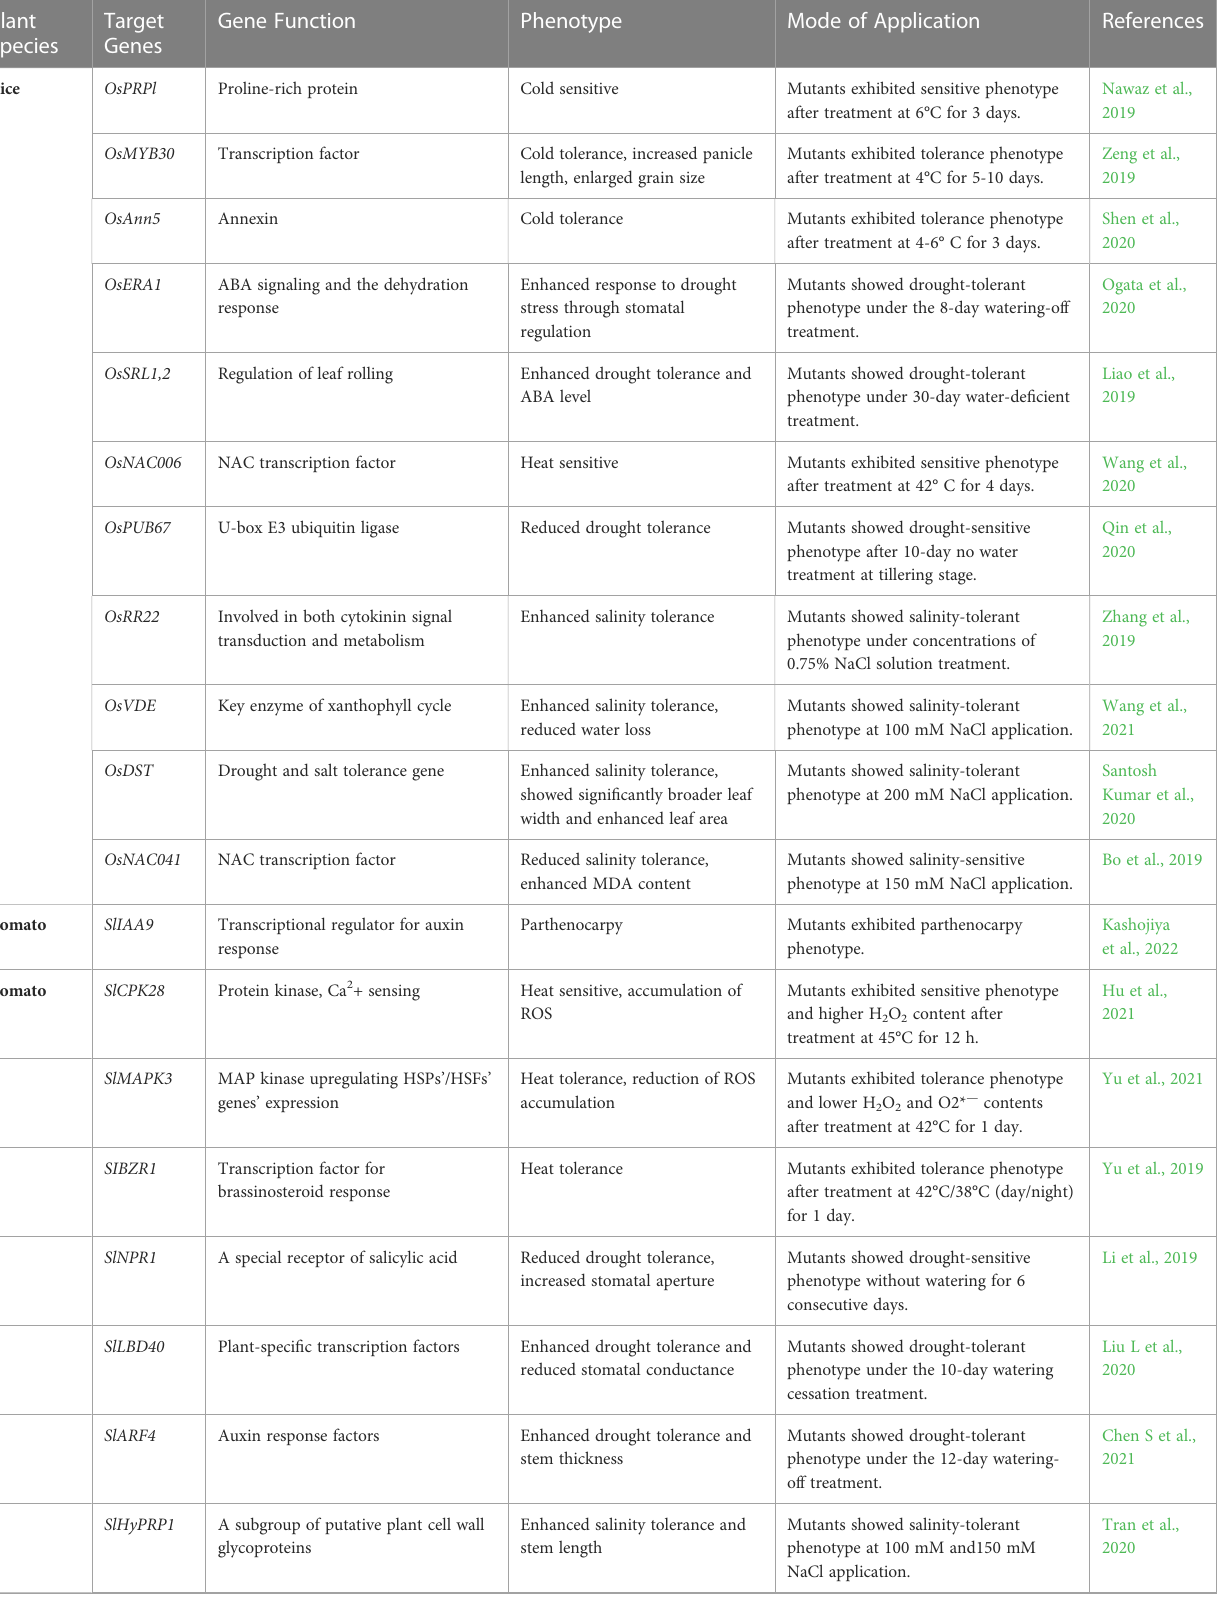
TABLE 1 Using genome editing CRSPR-Cas to from last four years to increase the ability of major food crops to withstand climate